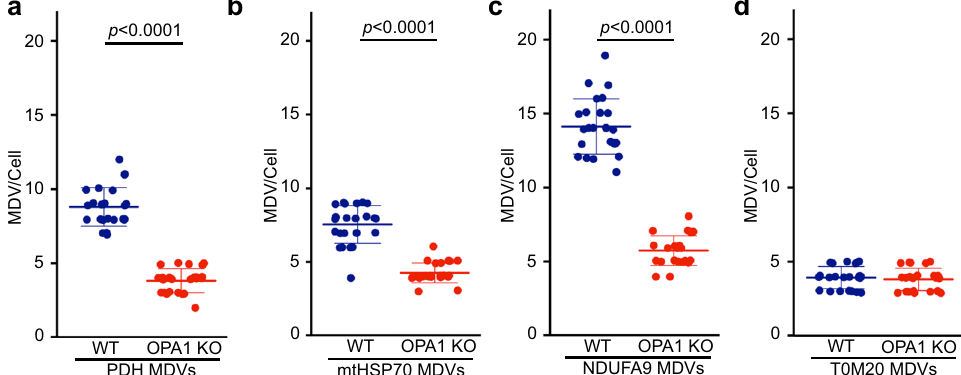
Fig. 4 OPA1 deletion inhibits the formation of IM/matrix MDVs. Quanti fi cation of MDVs positive for PDH ( a ), mtHSP70 ( b ), NDUFA9 (TOM20- negative) ( c ), as well as TOM20-positive (mtHSP70-negative) ( d ) in immuno fl uorescence images of WT (blue) and OPA1 KO (red) MEFs. Each data point represents one cell. Bars represent the average of 23 cells (except for PDH where n = 20) in three independent experiments ± SD. Two-sided t